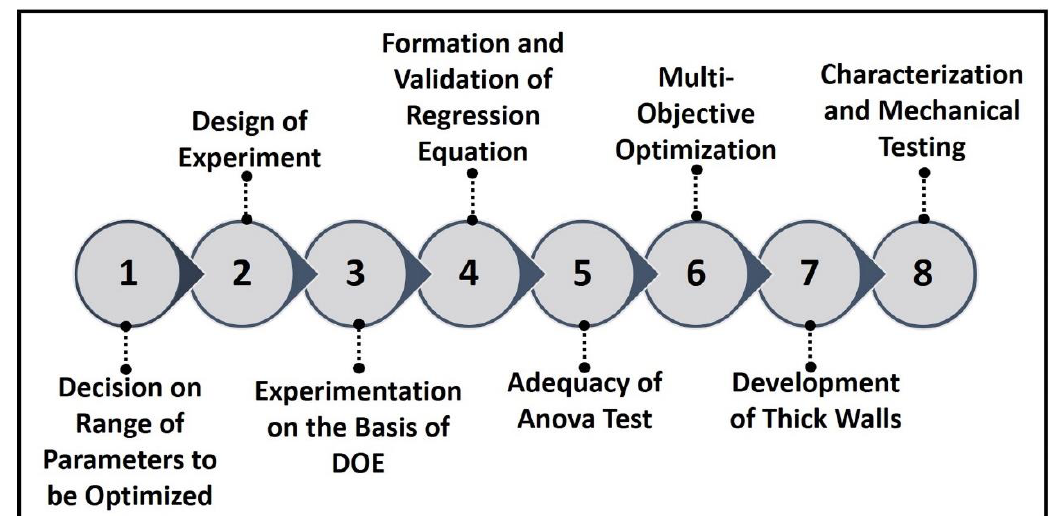
Figure 1. The step-by-step procedure followed in the current investigation to achieve the bulk fabrication of SS410 material using the WAAM process.